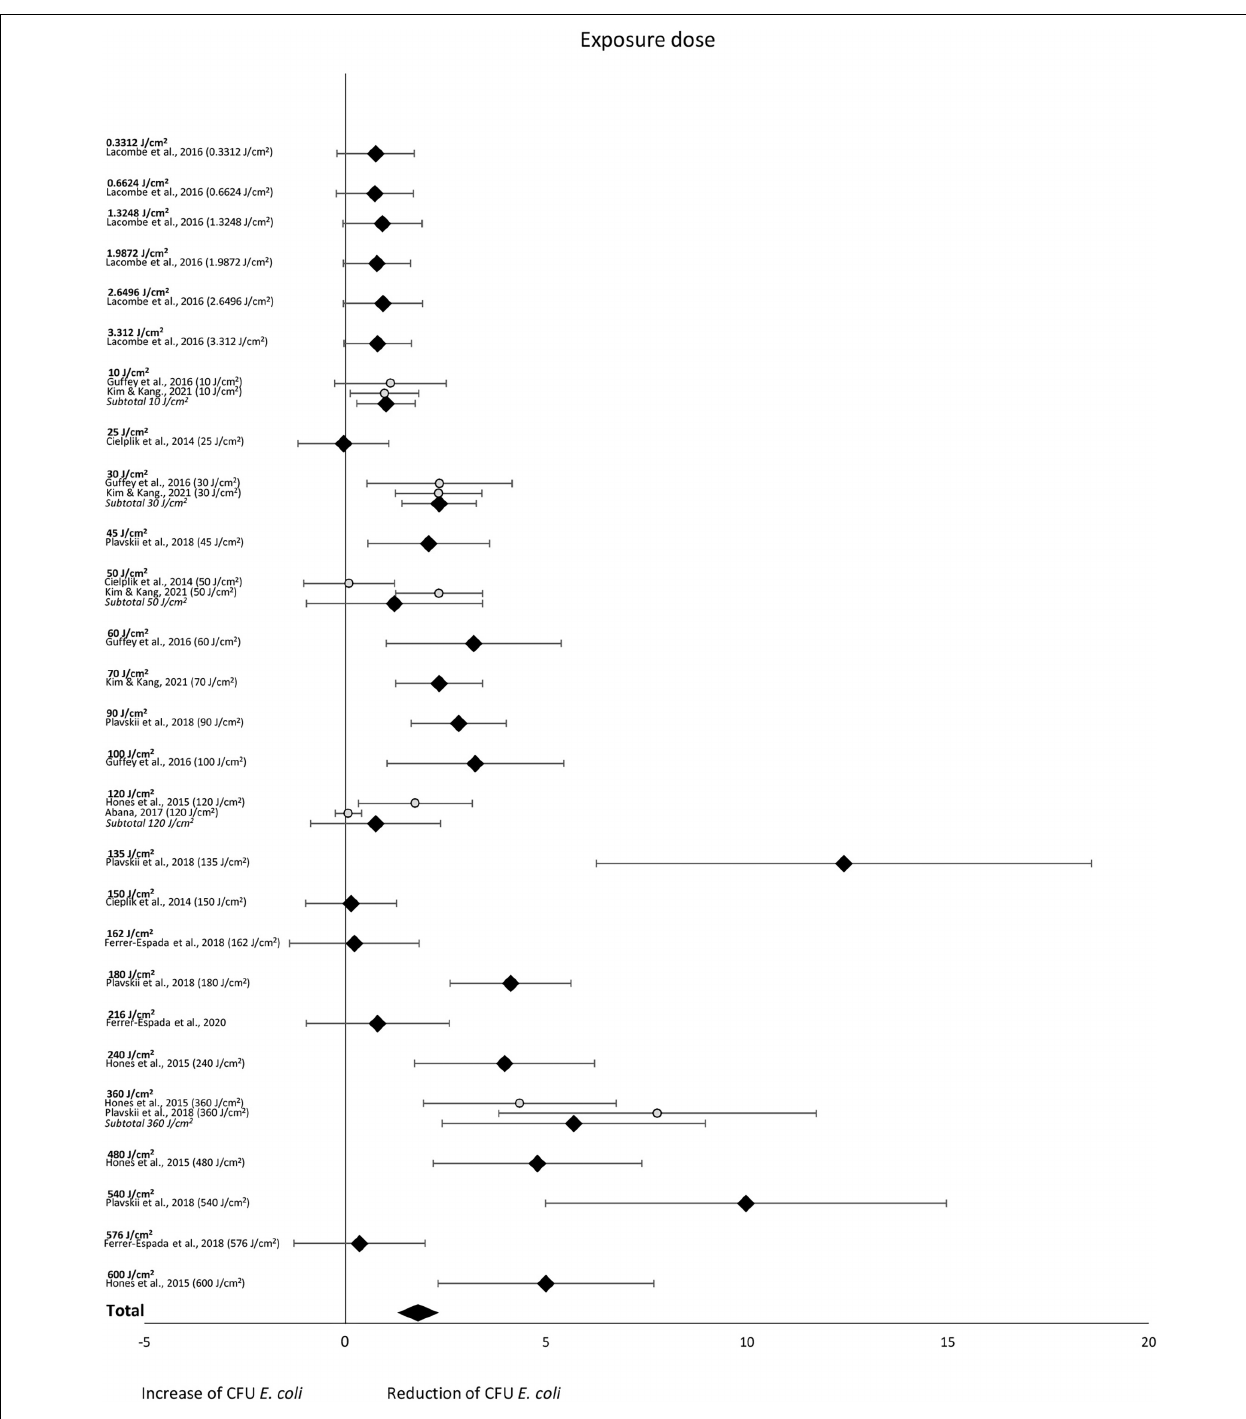
FIGURE 6 | Forest plot of reduction of E. coli post blue light exposure by exposure